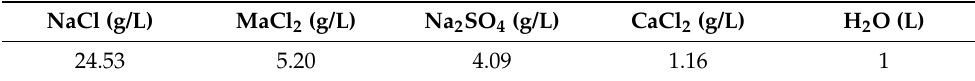
Table 2. Component of artificial seawater.